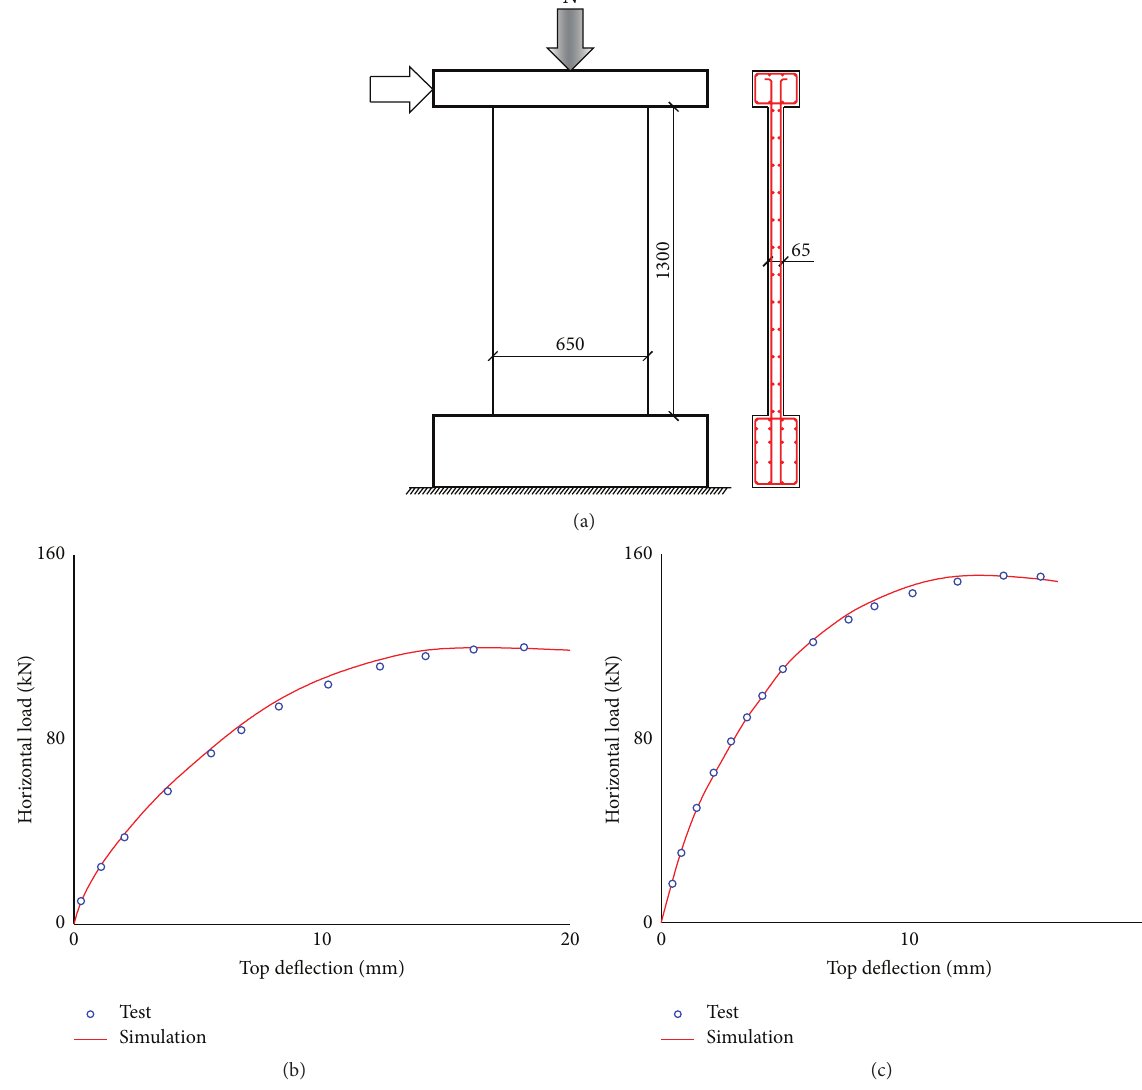
Figure 2: Reinforced concrete walls under in-plane loading [17]. (a) Setup (dimensions in mm). (b) Results for SW24 ( 𝑁 = 0 , 𝑓 cu = = 50.6 N/mm 2 48.3 N/mm 2 ). (c) Results for SW22 ( 𝑁 = 182 kN, 𝑓 cu